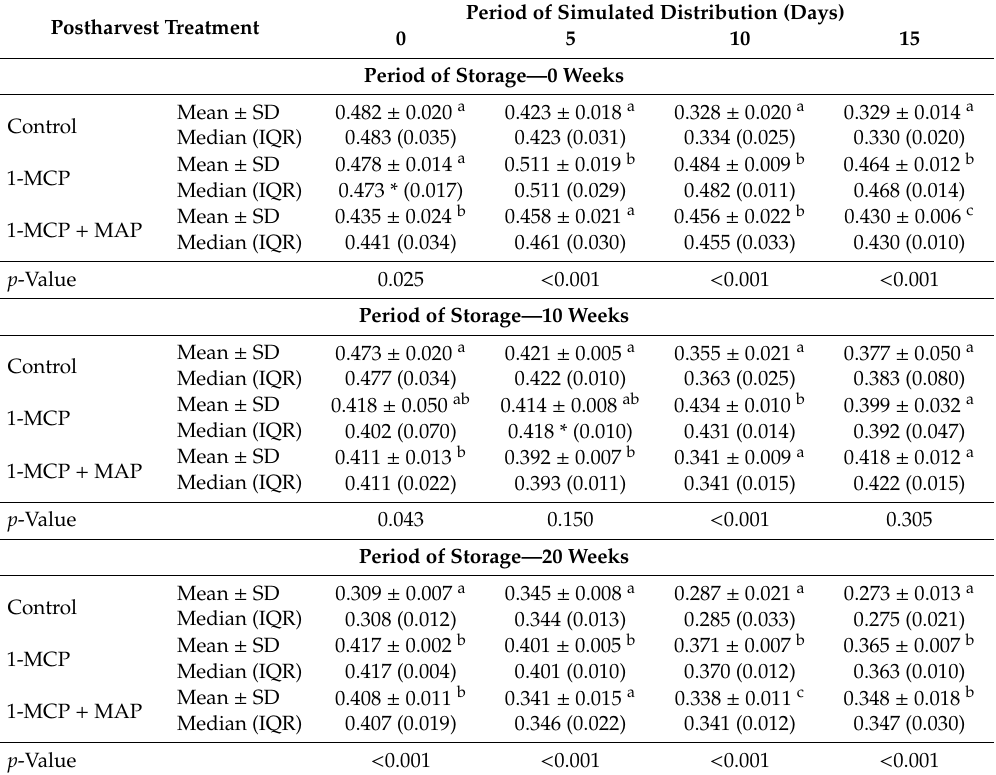
Table 4. The Titratable Acidity (TA) [%] values of ‘Idared’ apples after Ultra Low Oxygen (ULO) storage, simulated long-distance transport, and simulated distribution, stratified by postharvest treatment, period of storage and period of